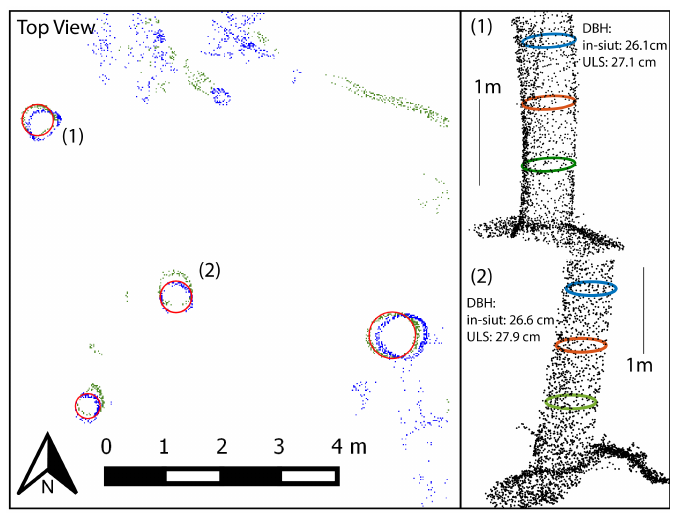
Figure 5. Point distribution and resulting diameters; Left figure shows horizontal sections of the point cloud from heights of 0.8–1.2 m above ground (green) and 1.4–1.8 m above ground (blue). To indicate stem irregularities and stem bending. Red circles indicate DBH estimated with cylinder fit. On the right side for the tree (1) and (2) the point cloud of the ULS is shown with the cylinder: Red circle at DBH height. Green and blue for heights of 0.8 m and 1.8 m (limits of section used for